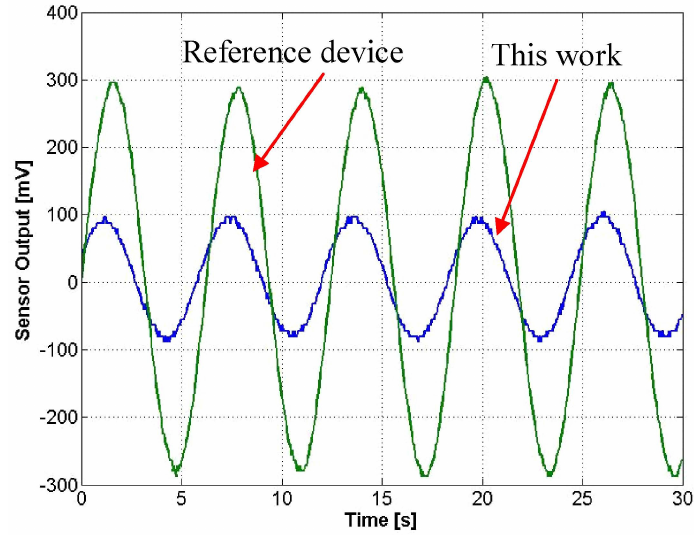
Figure 13. Waveforms of the DUT and reference accelerometer to a sinusoidal 3 g